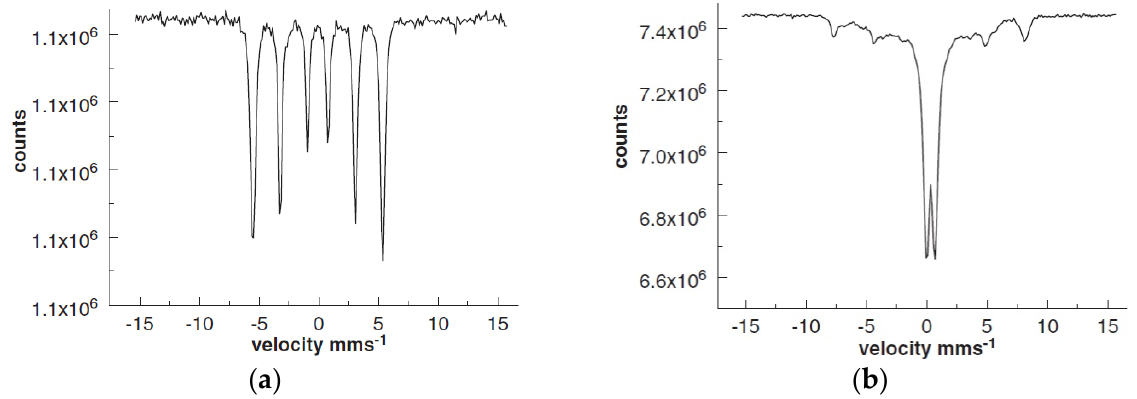
Figure 26. Room temperature Mössbauer spectra of unknown hexahedrite from Campo del Cielo meteorite shower: interior ( a ) and surface ( b ). Adapted from [72].